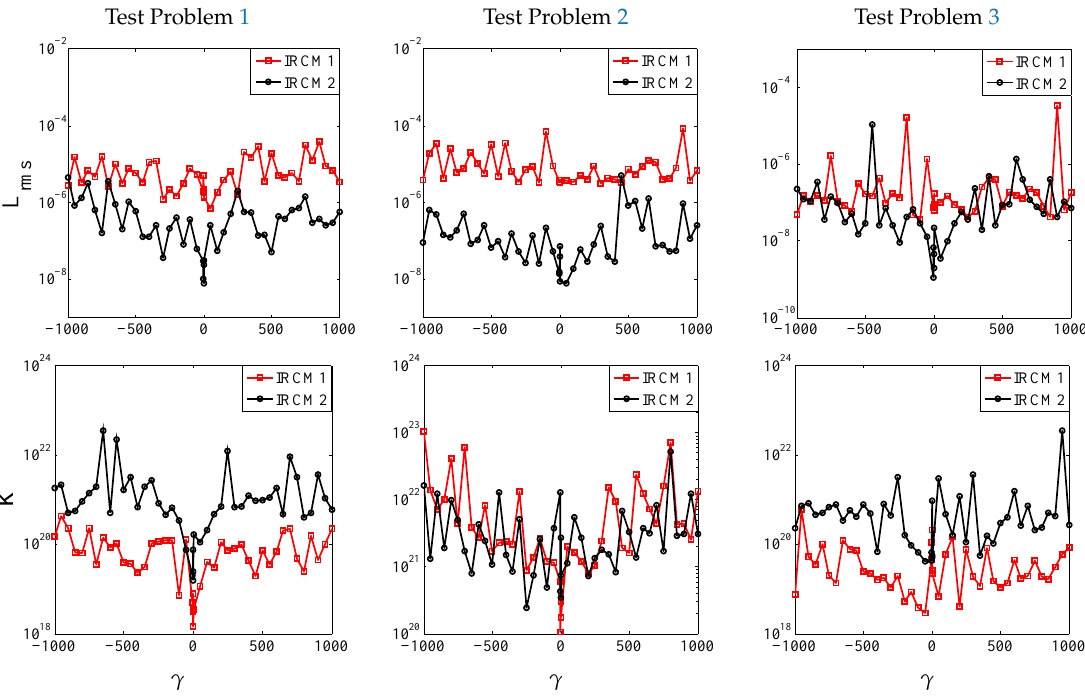
Figure 10. Test Problems 1–3, accuracy and κ versus γ and (cid:101) =